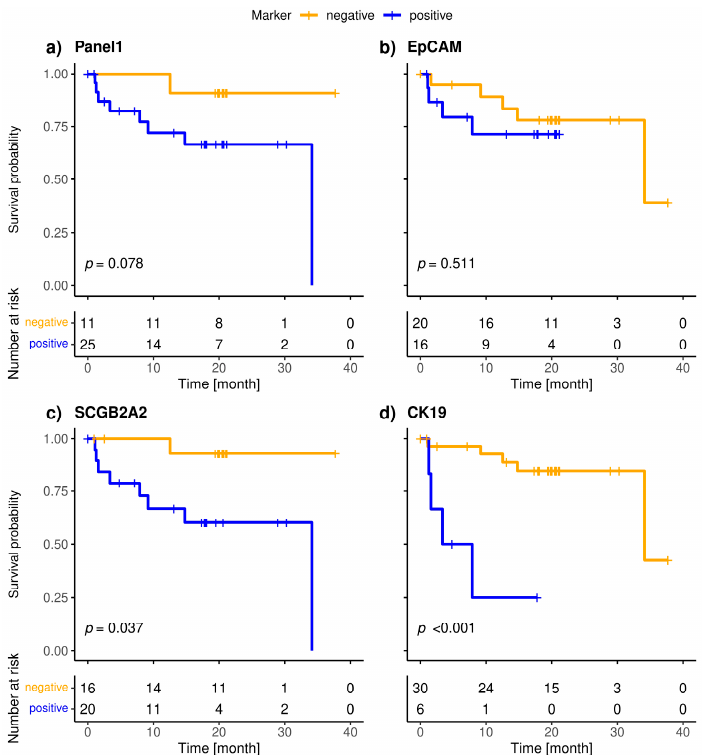
Figure 3. Kaplan-Meier plots of overall survival of metastatic breast cancer patients stratified by positivity (blue) of Panel 1 ( a ), CK19 ( b ), SCGB2A2 ( c ) and EpCAM ( d ); Bonferroni corrected p -values are shown, p < 0.05 is defined as level of significance.